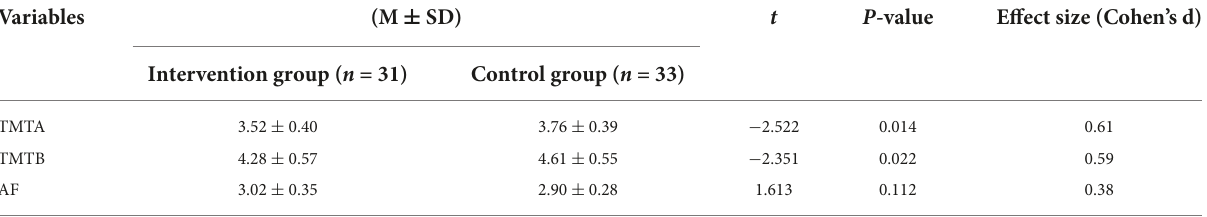
TABLE 4 Sensitivity analysis using independent t test for log-transformed skewed